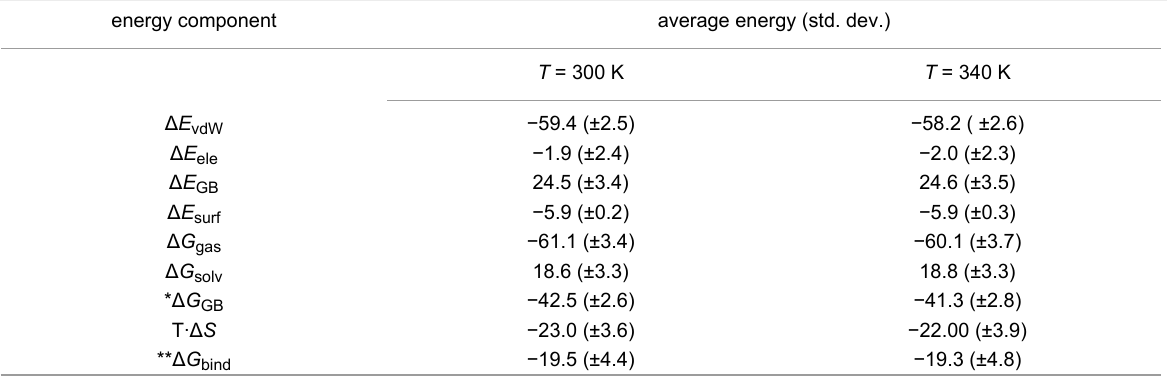
Table 2: Binding free energies (kcal/mole) resulting from MM/GBSA (and normal mode for the entropic term) analysis of the cholesterol/ β -CD inclu- sion compound. energy component average energy (std.